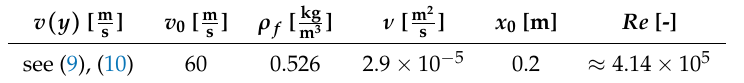
Table 5. Parameters for the simulation of a flow over an airfoil of a glider aircraft traveling at a height of 8000m adapted from [38] (example called Class 2). The sensor is located at x 0 on the airfoil with respect to front edge.